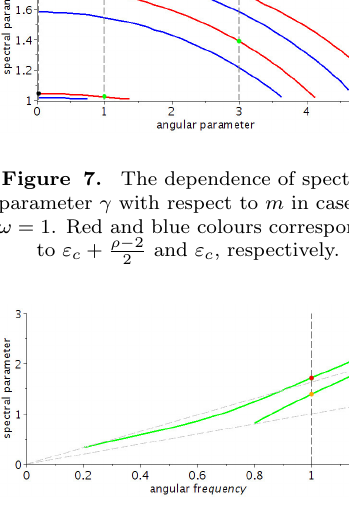
Figure 9. The dependence of spectral parameter γ with respect to frequency ω (dispersion curves) in case of m = 3. The . permittivity is specified by ε c + ρ − 2 20